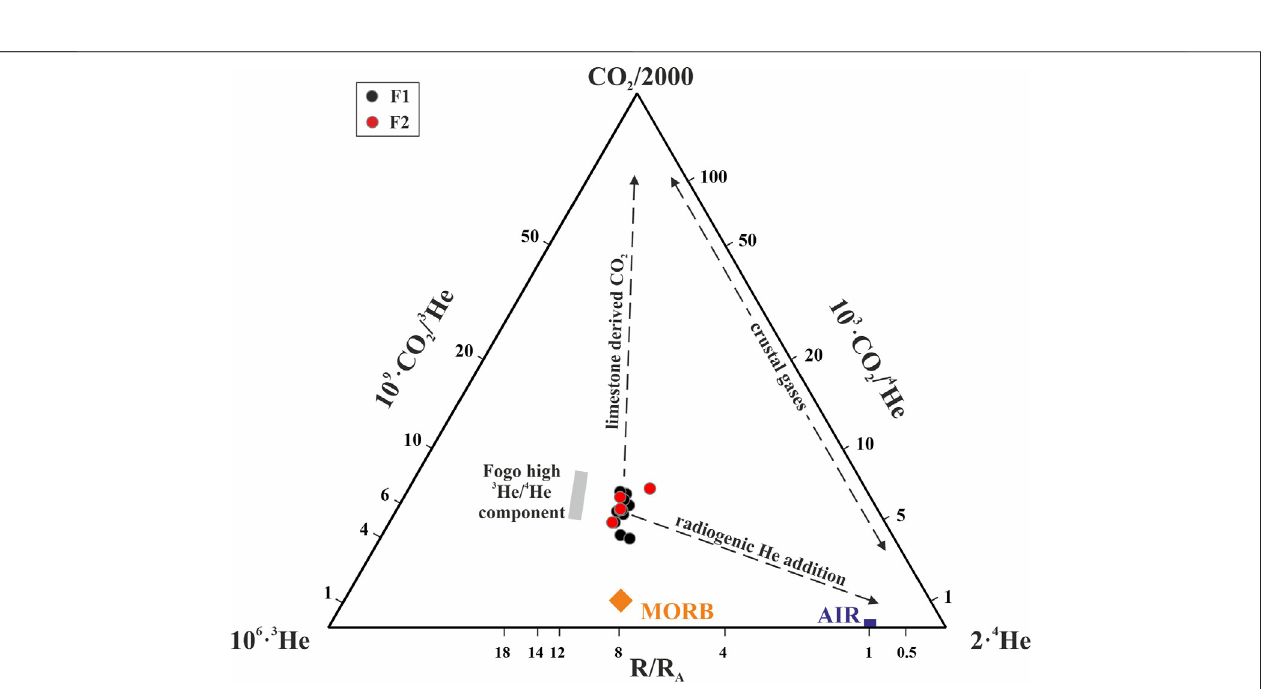
FIGURE 8 | CO 2 , 3 He and 4 He relative compositions of the fumarolic samples from Fogo volcano (Giggenbach et al., 1993; Barry et al., 2013). MORB (8 ± 1 R A , Graham, 2002; CO 2 / 3 He (cid:2) 2 ± 1 × 10 9 , Marty and Jambon, 1987) and Air (1 R A , Graham, 2002; CO 2 / 3 He (cid:2) 1 × 10 9 , Marty and Jambon, 1987) are also reported. Gray rectangle represents the Fogo high 3 He/ 4 He component.